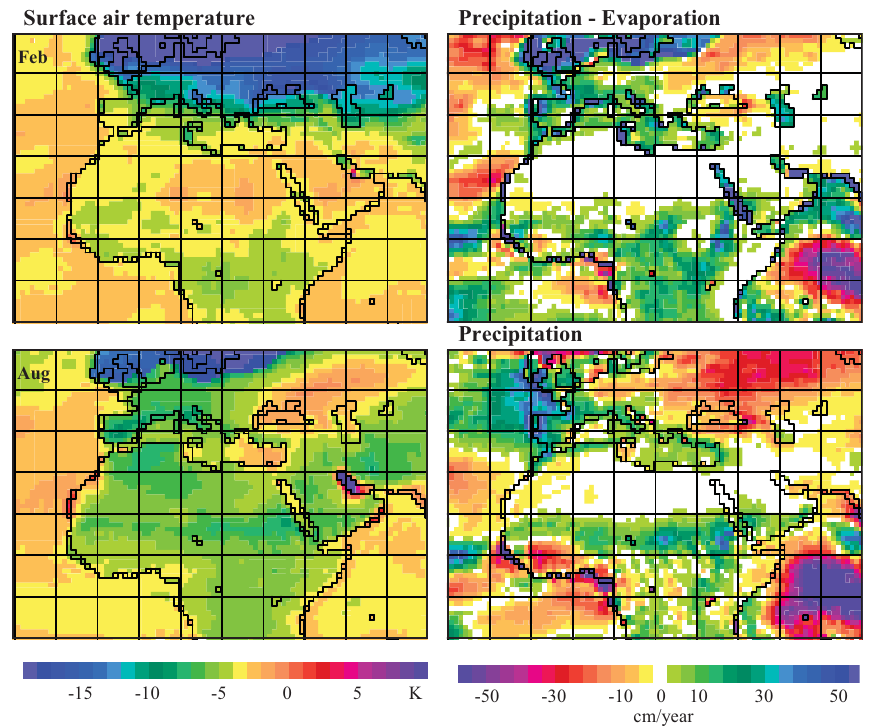
Fig. 6. Difference between LGM and present day simulations with the stand-alone ECHAM5 T106 atmospheric model. Left: Difference in surface air temperature between LGM and present day in K for February (top) and August (bottom). Right: difference in annual mean precipitation minus evaporation (top) and precipitation (bottom). Contour interval is 4cm / yr, white colour indicates changes less than 2cm / yr. Both present day and LGM coastlines are